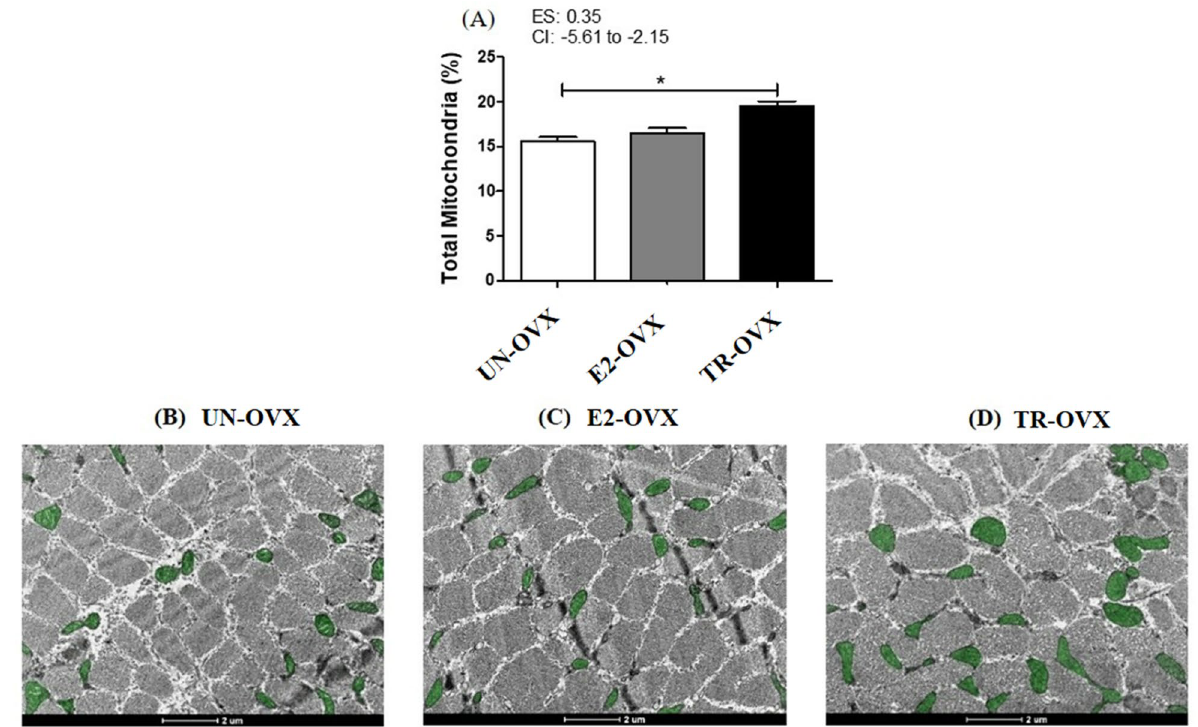
Figure 2. Mitochondrial muscle density. ( A ). Quantification of total mitochondria muscle density in mid- belly fragments of the right soleus from untrained ovariectomized rats (UN-OVX), ovariectomized rats treated with Estradiol replacement (E2-OVX), and trained ovariectomized rats (TR-OVX). N = 72 fields from three animals per group. ( B – D ) Transmission electron micrographs (TEM) of transverse sections of muscle fibers (ultra-structural view), in which mitochondria is highlighted in green. Data are reported as mean ± S.E.M. 95% confidence interval (CI). Effect size (ES) *p < 0.01. One-way ANOVA followed by Dunnet posthoc